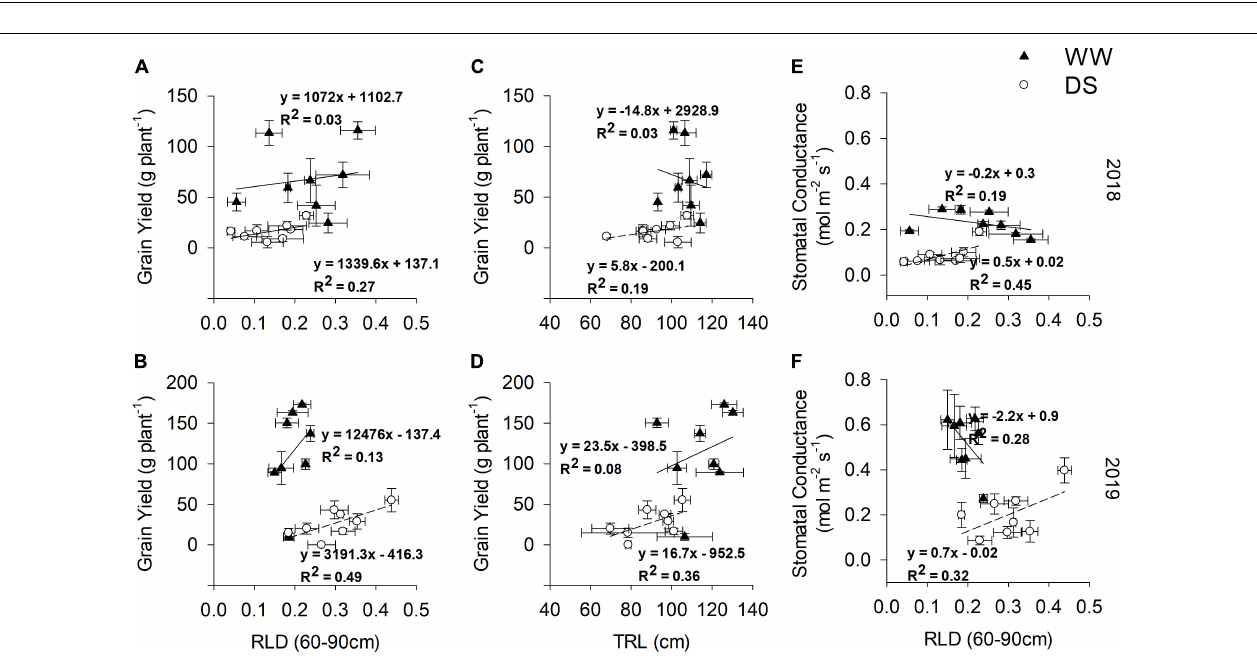
FIGURE 10 | ANOVA for grain yield (g plant − 1 ) in two seasons (A) 2018 and (B) 2019 under WW and DS. The data is mean ± SE values ( n = 3) with different letters showing significant differences by Tukey’s honest significant difference post hoc test for treatments.